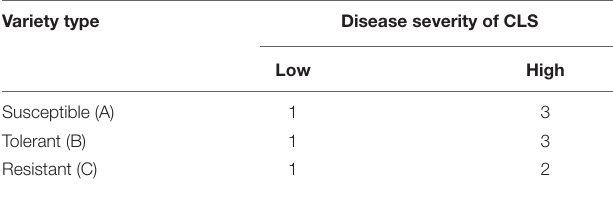
TABLE 3 | Number of fungicide applications according to the threshold system (Wolf and Verreet, 2002; Lang, 2005) in sugar beet varieties susceptible, tolerant, and resistant to Cercospora beticola at environments with disease severity (DS) < 5 (low) and DS ≥ 5 (high); rating according to BSA